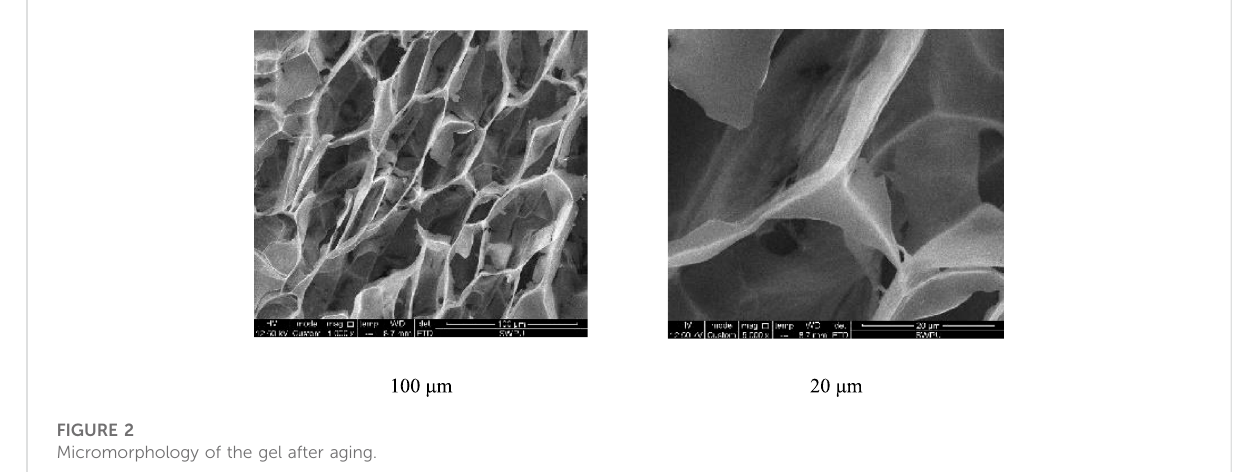
FIGURE 2 Micromorphology of the gel after aging.